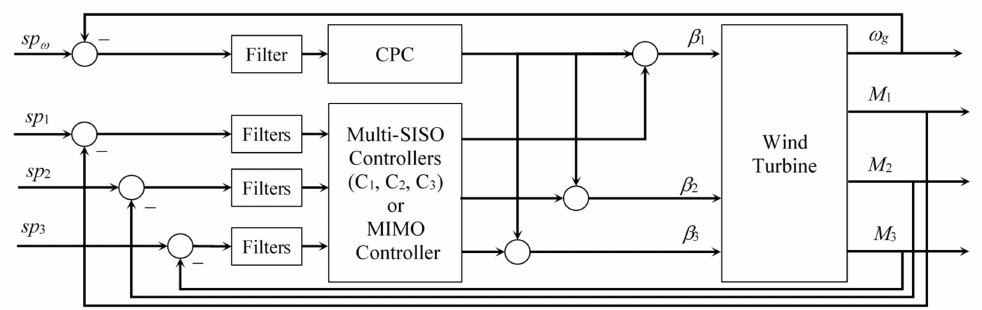
Figure 9. Control system configuration of the IPC without